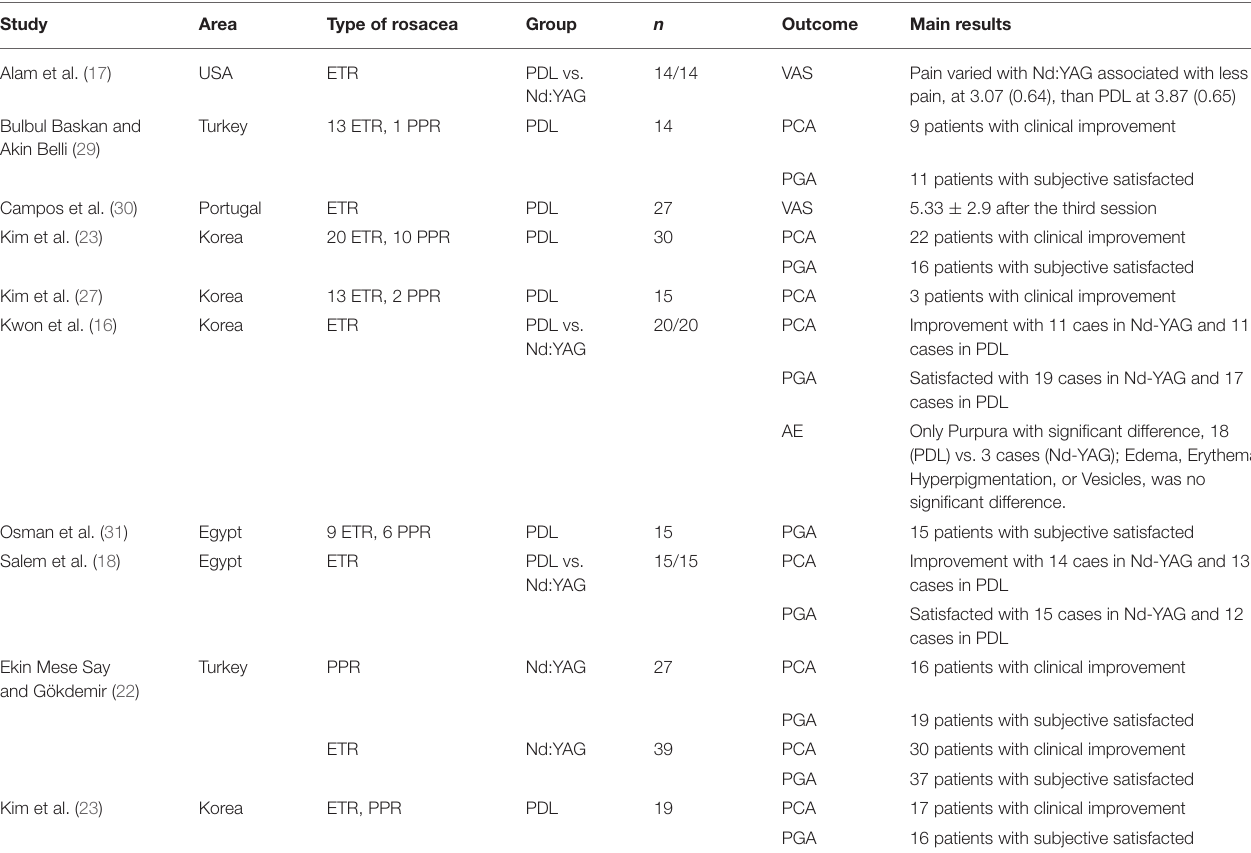
TABLE 3 | The main outcomes and results of each of the included study.